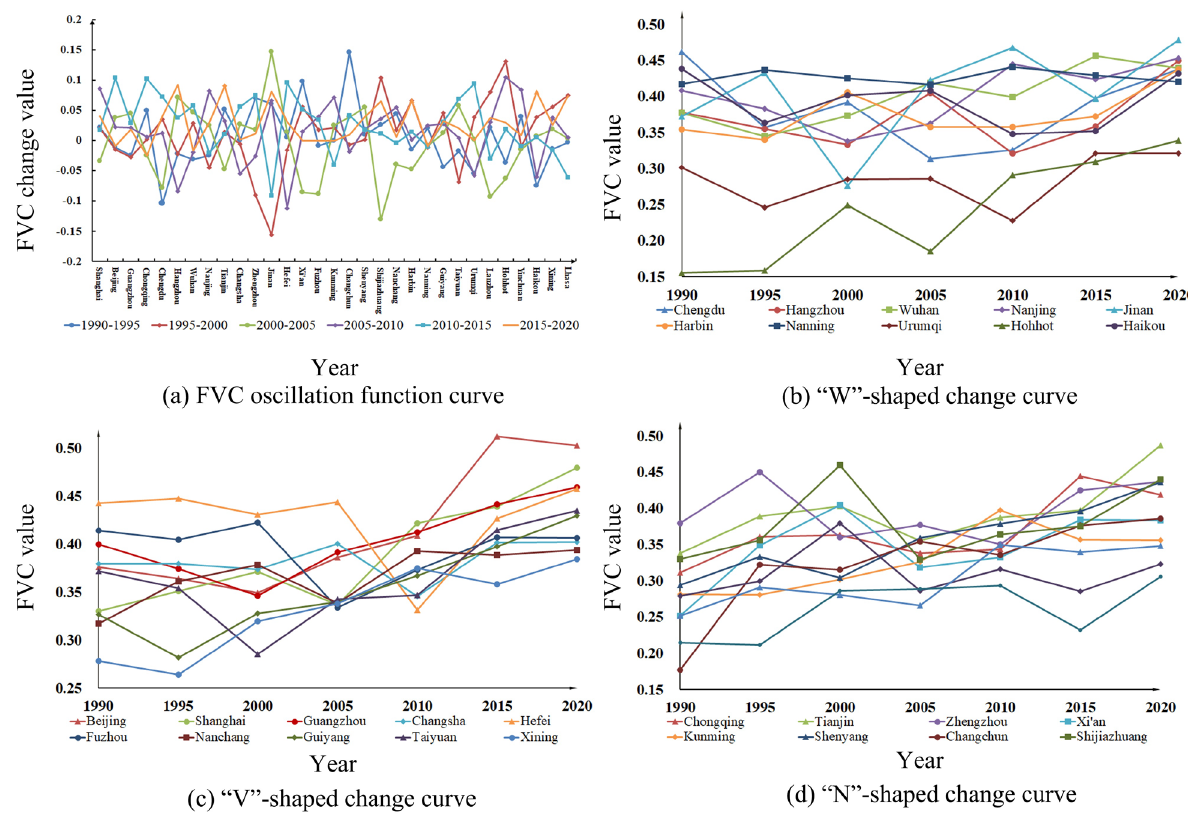
Figure 9. FVC changing curves of built-up areas of provincial capital cities from 1990 to 2020.